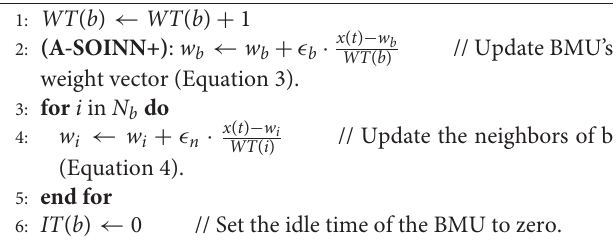
Algorithm 3 . (Associative) SOINN+ Node Merging Algorithm 4 . (Associative) SOINN+ Node